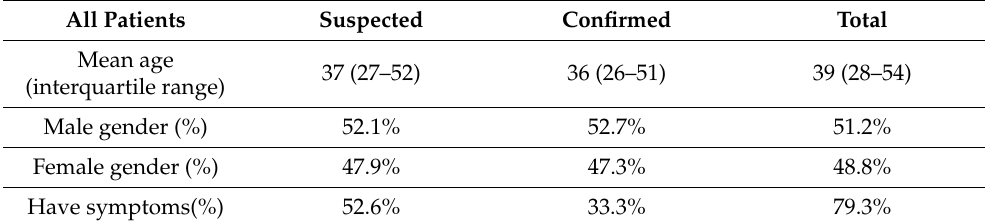
Table 2. Male and female demographics.